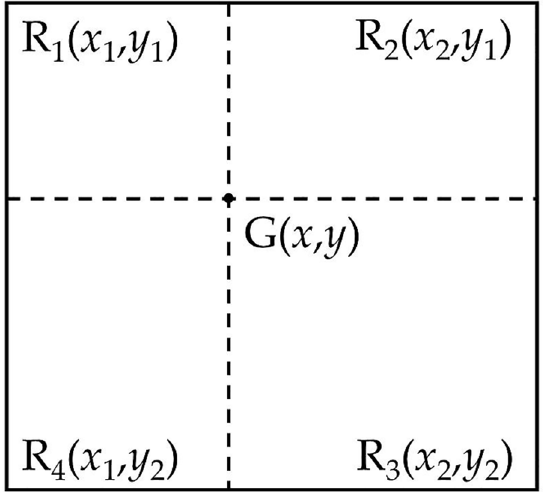
Figure 3. Schematic diagram of bilinear interpolation.